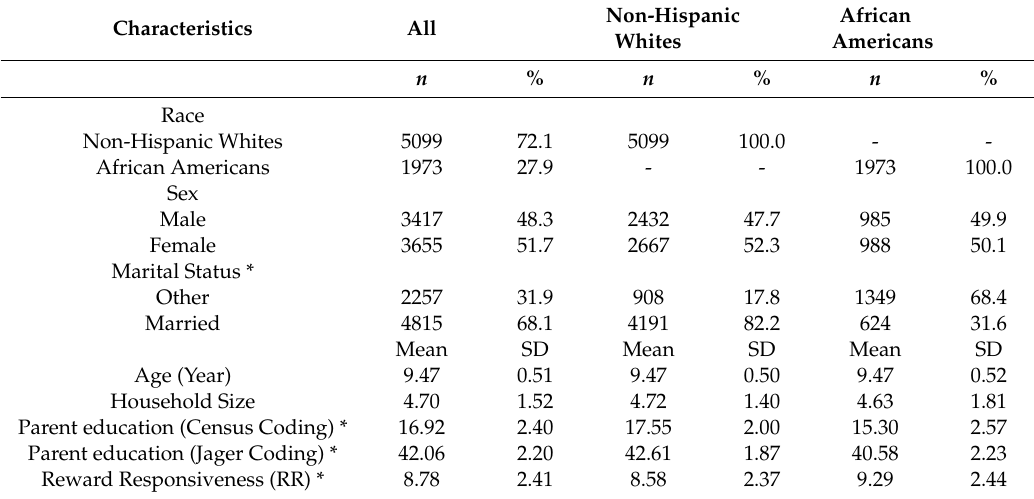
Table 1. Data overall and by race ( n =